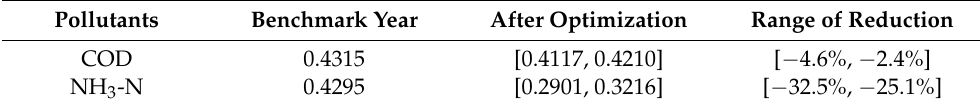
Table 5. Changes in the comprehensive Gini coefficient after optimal allocation.